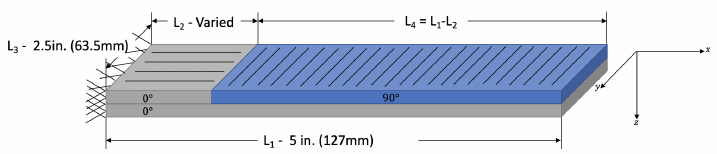
Figure 3. Schematic showing the lay-up structure of the rectangular laminate